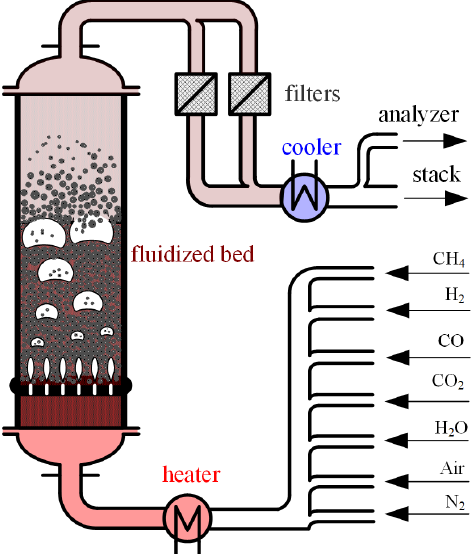
Figure 4. Batch-fluidized bed reactor setup.